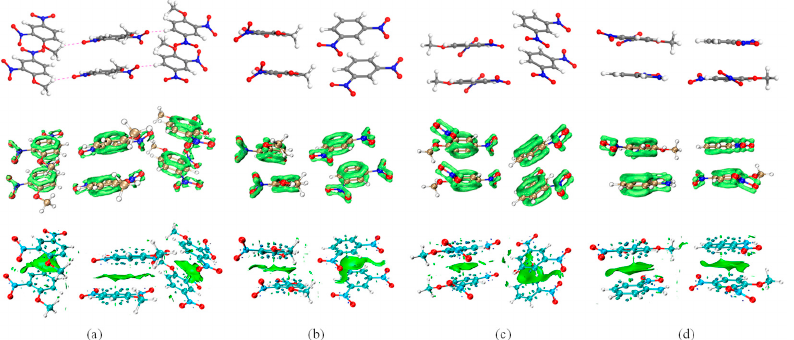
Figure 3. Interlayer interaction illustration of DNAN ( a ), DNAN/DNB ( b , c ) and DNAN/NA ( d ). Representative clusters in Ball-Stick models ( top row), LOL- π ( middle row), and IRI- π ( bottom row). Bright green surface denotes the LOL- π isosurface (the isovalue is 0.5 a.u.) and IRI- π (the isovalue is 1.0 a.u.) in middle and bottom row, respectively.